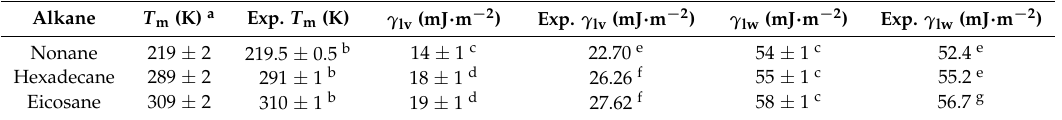
Table 1. Comparison of thermodynamic properties of PYS alkanes and their interfaces with mW water with the experimental (‘exp.’) counterparts.